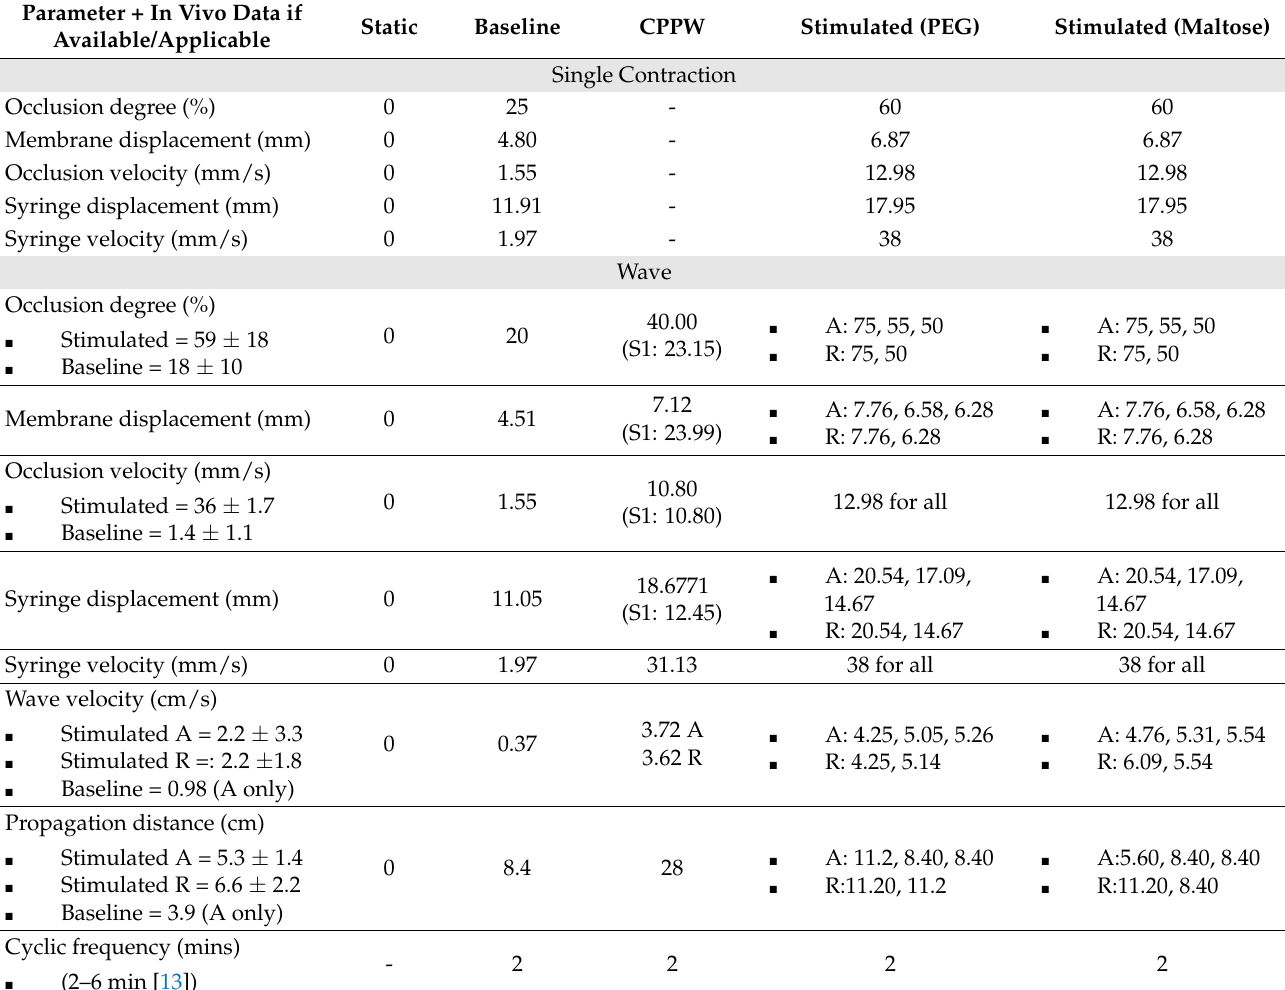
Table 2. Motility parameters of the static, baseline, CPPW (A = Antegrade, R = Retrograde) and stimulated (PEG or maltose) motility patterns applied to the DCM in this study, including the in vivo range where in vivo data is available. Static Baseline CPPW Stimulated (PEG) Stimulated (Maltose) Single